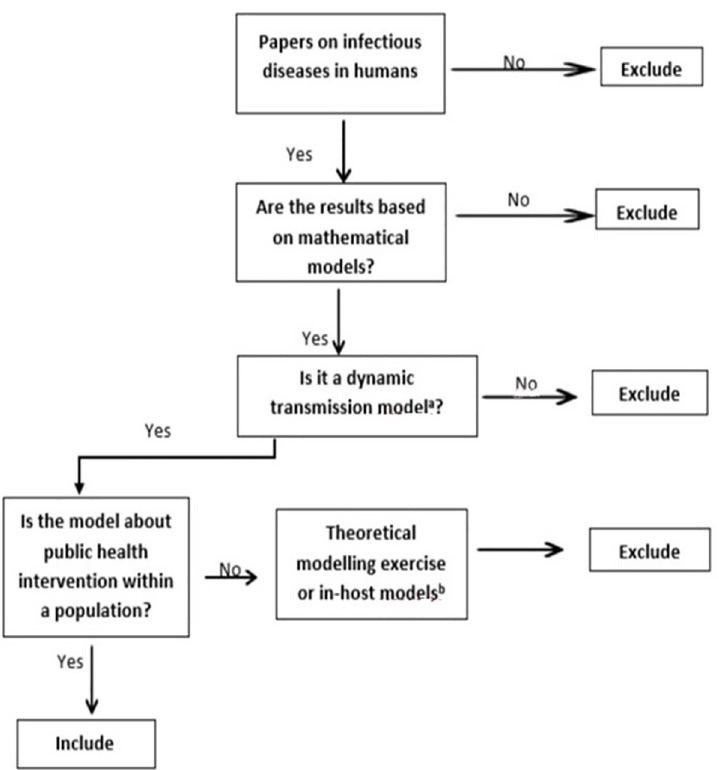
Fig 1. The screening algorithm used to determine the eligibility of literature for review. a Dynamic transmission models are mathematical models in which transmission is determined endogenously [17]. b Theoretical models are used to understand transmission dynamics but informing to public health action or policy is not their primary aim [17].